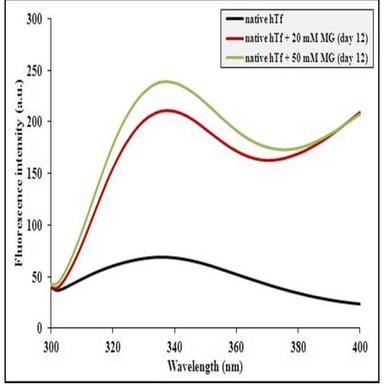
Intrinsic fluorescence. Emission spectra of native hTF and hTF incubated with methylglyoxal. Excitation wavelength was 280 nm while spectra were recorded in the range of 300–400 nm. The protein concentration in the final aliquot was 4 μM.